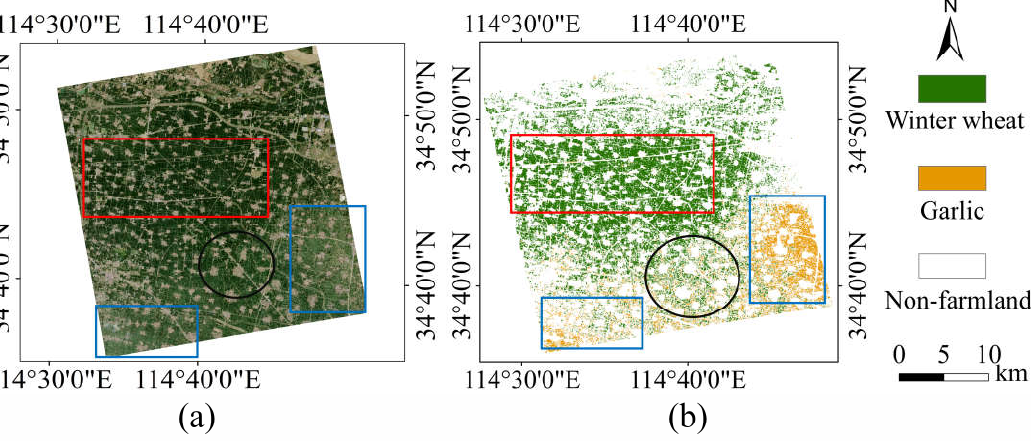
Figure 10. ( a ) Sentinel-2 image of the study area on 17 April 2020. ( b ) Spatial distribution map of crops in Kaifeng in 2020. crops in Kaifeng in